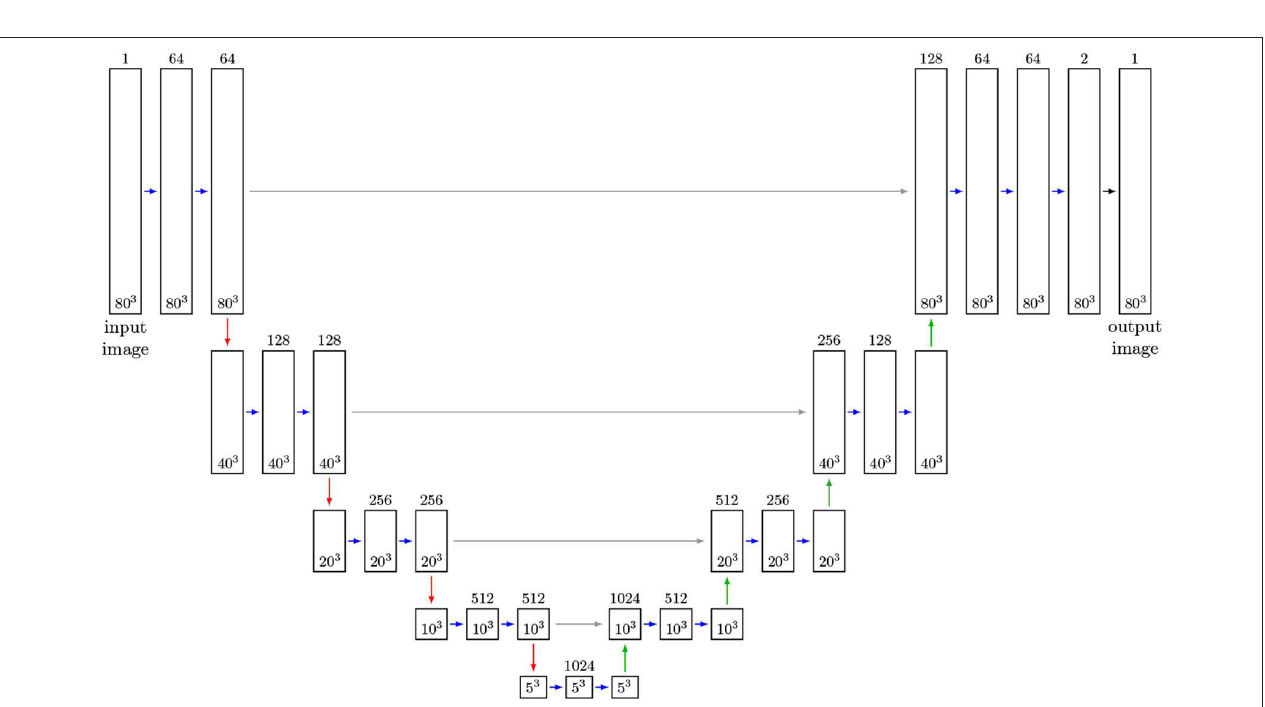
FIGURE 7 | Adapted 3D U-Net architecture (Ronneberger et al., 2015): Feature maps are represented by boxes, where the number of channels is indicated by the number above the box. Blue arrows indicate convolutional layers with kernel size of 3 × 3 × 3 and ReLu activation functions. Red arrows describe max-pooling layers of size 2 × 2 × 2. Up-convolutional layers of size are 2 × 2 × 2 indicated by green arrows. Merge layers are visualized by gray arrows. The layer (black arrow) generating the output is a convolutional layer with kernel size 1 × 1 × 1 and a sigmoid activation function. The sizes of input, feature and output images during training is given in the boxes. After training the network can receive arbitrarily sized images as input, provided their size in each direction is a multiple of 2 4 =